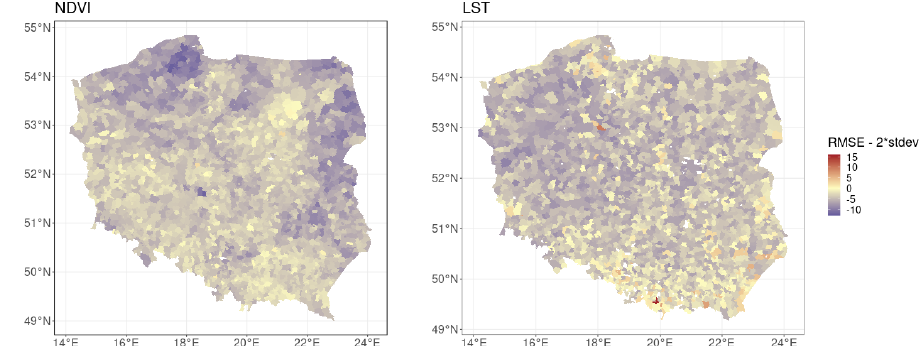
Figure 6. Monthly differences (May) for LAU units between cross-calibration error (RMSE) and the natural variability of the MODIS-derived predictors expressed as double standard deviation. The negative differences (blue colours) indicate that the calibration error is lower than the natural